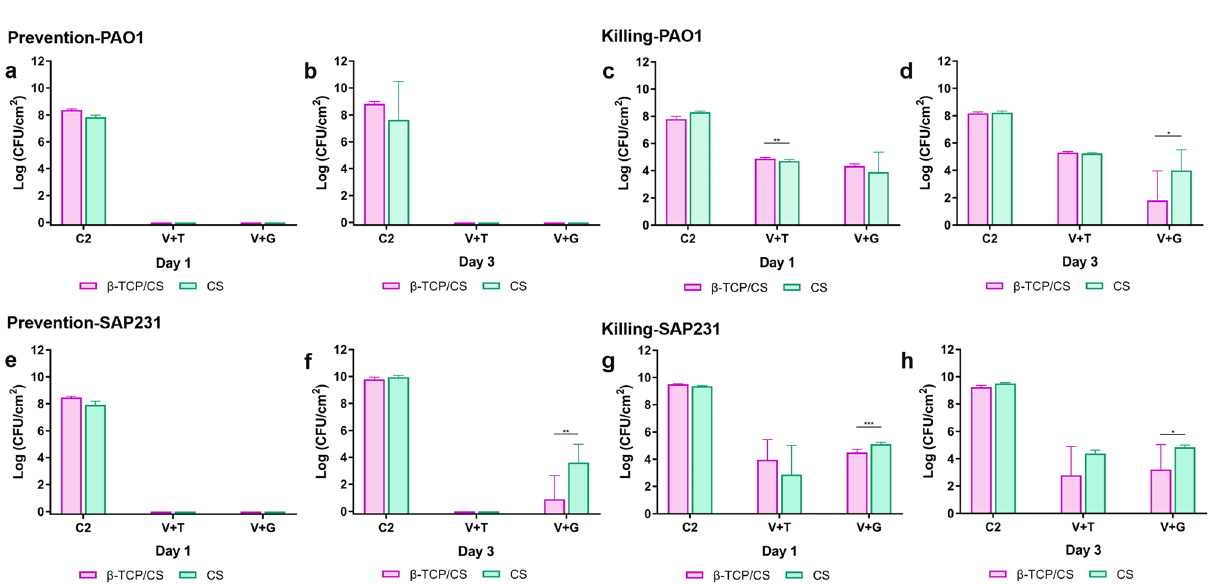
Figure 3. Comparisons of the P. aeruginosa PAO1 and S. aureus SAP231 CFU counts following treatment with β-TCP/CS or CS beads. Data expressed as means of 9 data points with standard deviation bars. (PAO1: ( a )–( d ); SAP231: ( e )–( h ). C2 represents controlled group with unloaded beads; * P < 0.05, ** P < 0.01, *** P <